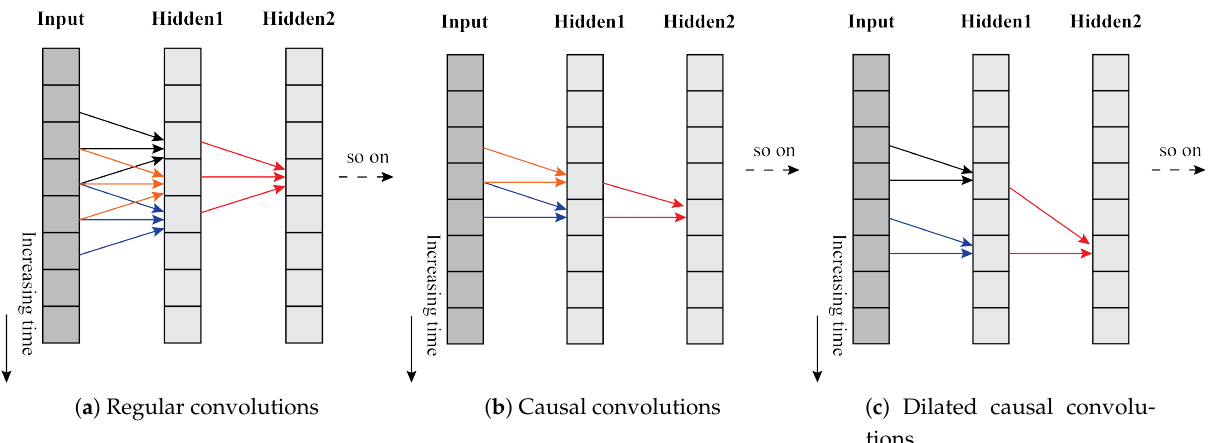
Figure 6. Different types of 1D convolutions for a time window of 8 and a single feature or